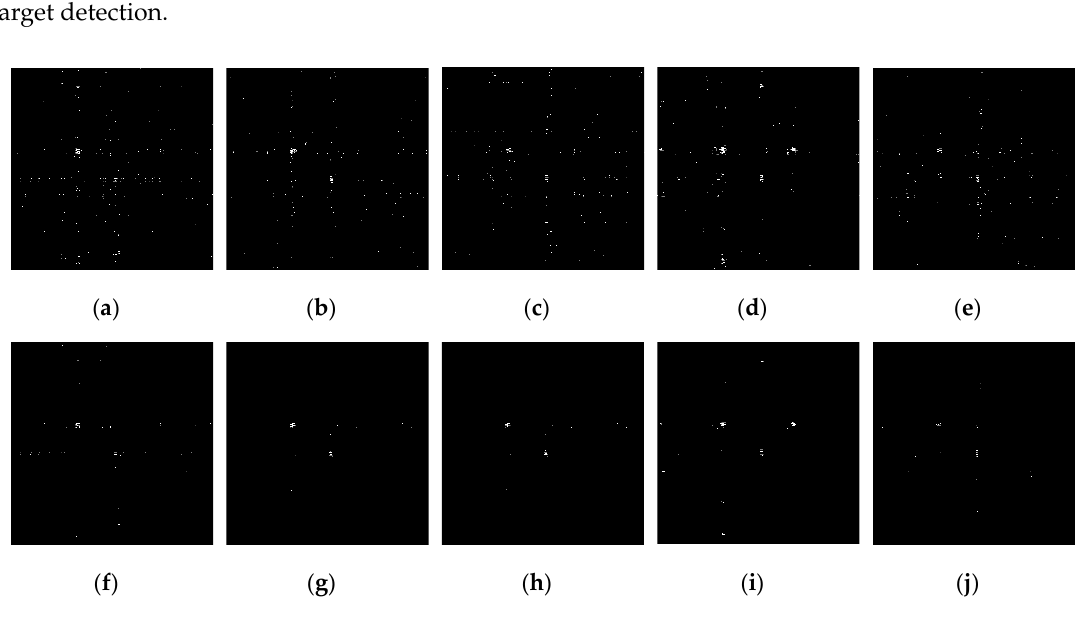
Figure 6. The threshold partition image by the initial threshold and the adaptive threshold of different measurement matrixes: ( a ) Initial threshold partition image mapping by Gauss, ( b ) Initial threshold partition image mapping by Part Hadamard, ( c ) Initial threshold partition image mapping by Bernouli, ( d ) Initial threshold partition image mapping by Circulant, ( e ) Initial threshold partition image mapping by Toeplitz, ( f ) Adaptive threshold partition image mapping by Gauss, ( g ) Adaptive threshold partition image mapping by Part Hadamard, ( h ) Adaptive threshold partition image mapping by Bernouli, ( i ) Adaptive threshold partition image mapping by Circulant, ( j ) Adaptive threshold partition image mapping by Toeplitz.